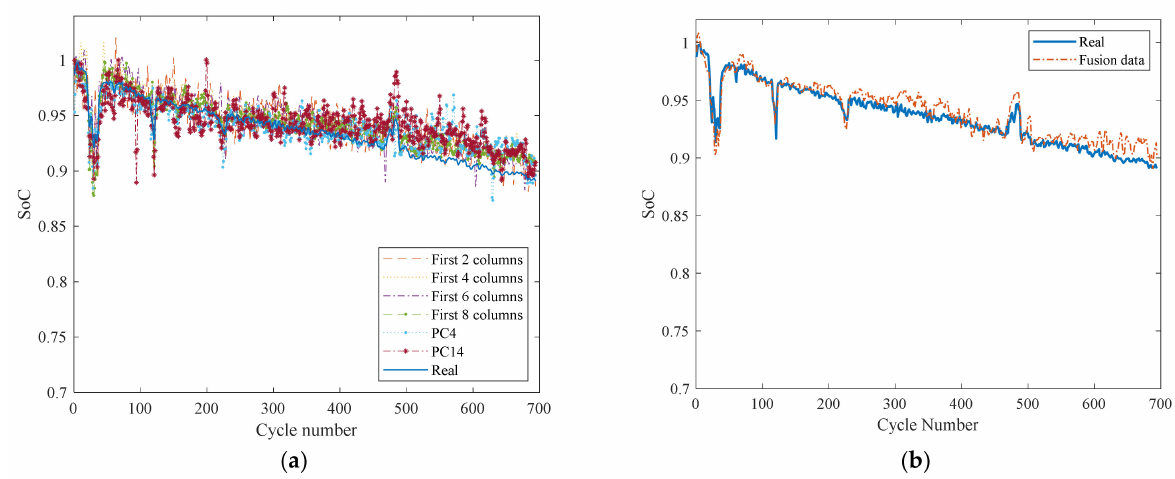
Figure 15. The prediction results of ( a ) a variety of PC matrices and the original matrix with different columns and ( b ) fusion data